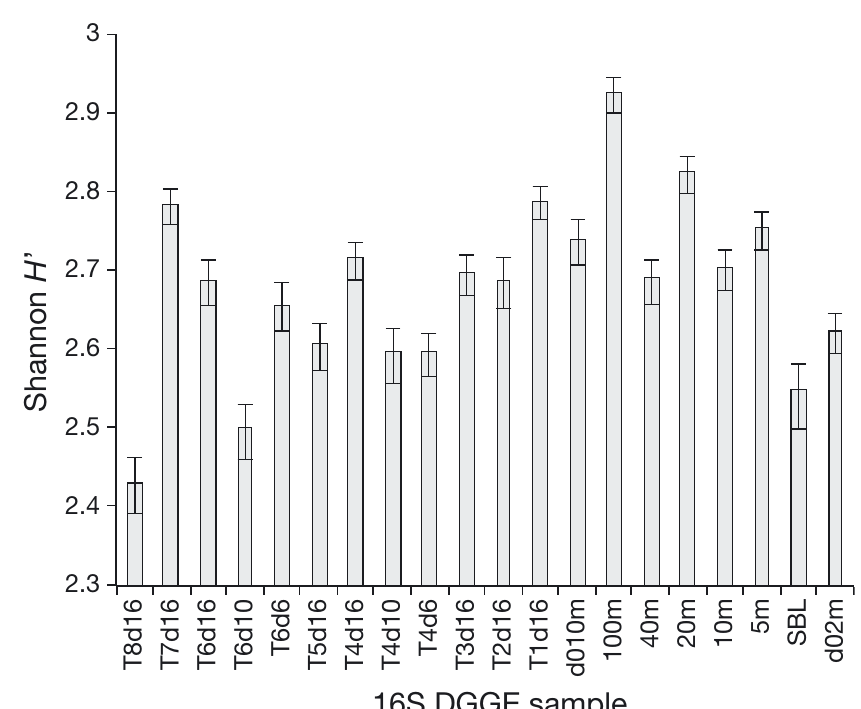
for chl a followed the ammonium vertical pattern, showing a subsurface maximum in concentration at 10 and 15 m of 0.5−0.6 µg chl a l −1 , decreasing at deeper waters (0.2 µg l −1 ; Fig. 6). The pH was 7.6 in the deep water and increased to 8.2 from 10 to 5 m depth (Fig. 6).